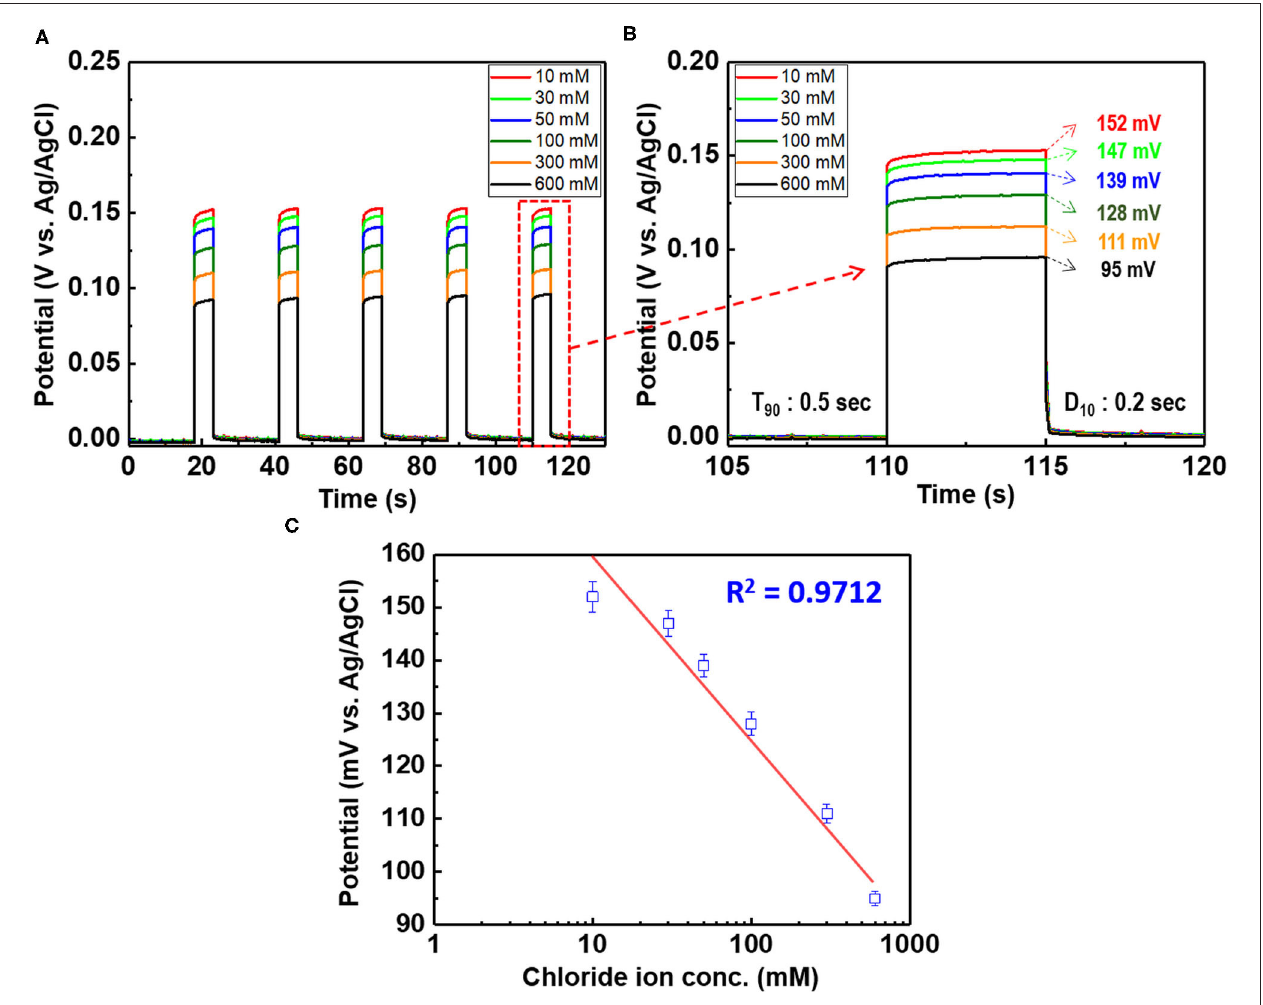
FIGURE 9 | (A) Potential difference of the chloride ion sensor (D: 1cm, L: 4cm Ag/AgCl) as a function of the chloride ion content of 10–600mM KCl and (B) magnified image of the fifth bar (enclosed in red rectangle) in (A) . (C) Linear fitting of the chloride ion sensor potential with the experimental data. The applied current pulse is fixed at